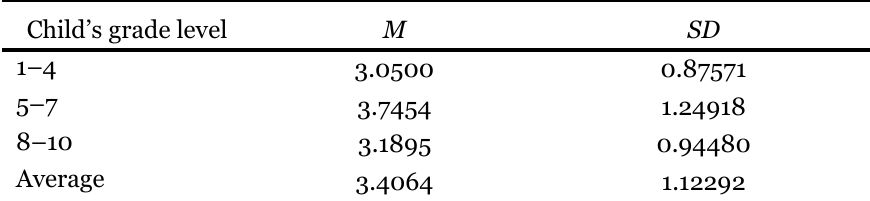
Means and Standard Deviations of Parents’ Perceptions Toward the Distance Learning Process According to Child’s Grade Level